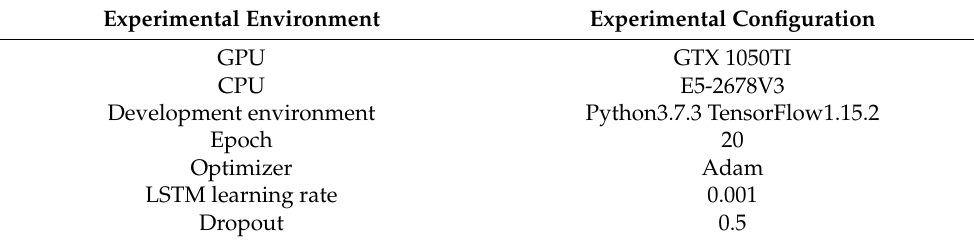
Table 1. Experimental environment setting.